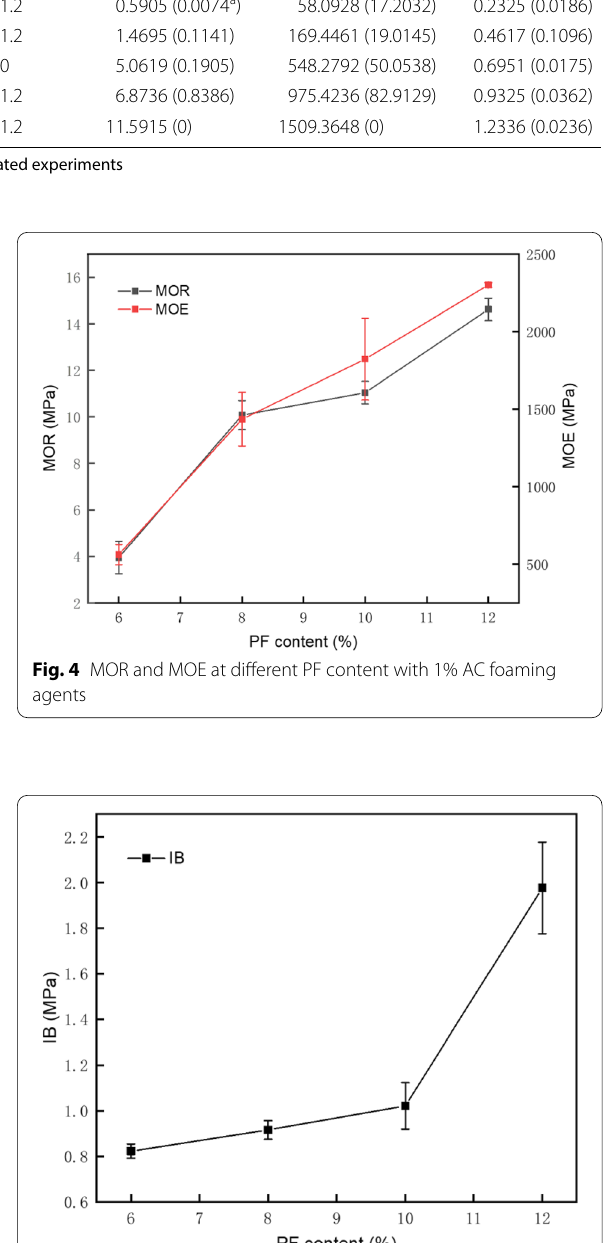
Table 2 Mechanical properties of foaming particleboard with different densities Number Particleboard design density (g/cm 3 )